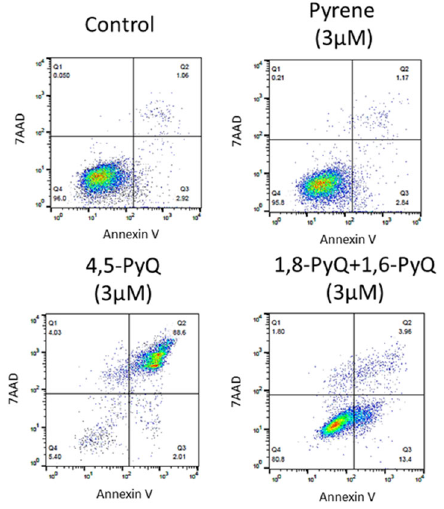
Figure 2. Effects of pyrene and its quinone forms on the apoptosis and necrosis of human bronchial epithelial cells. Dot ‐ plot of flow cytometry, Q1, necrotic cells; Q2, late apoptotic or necrotic cells; Q3, early apoptotic cells; Q4, healthy cells.